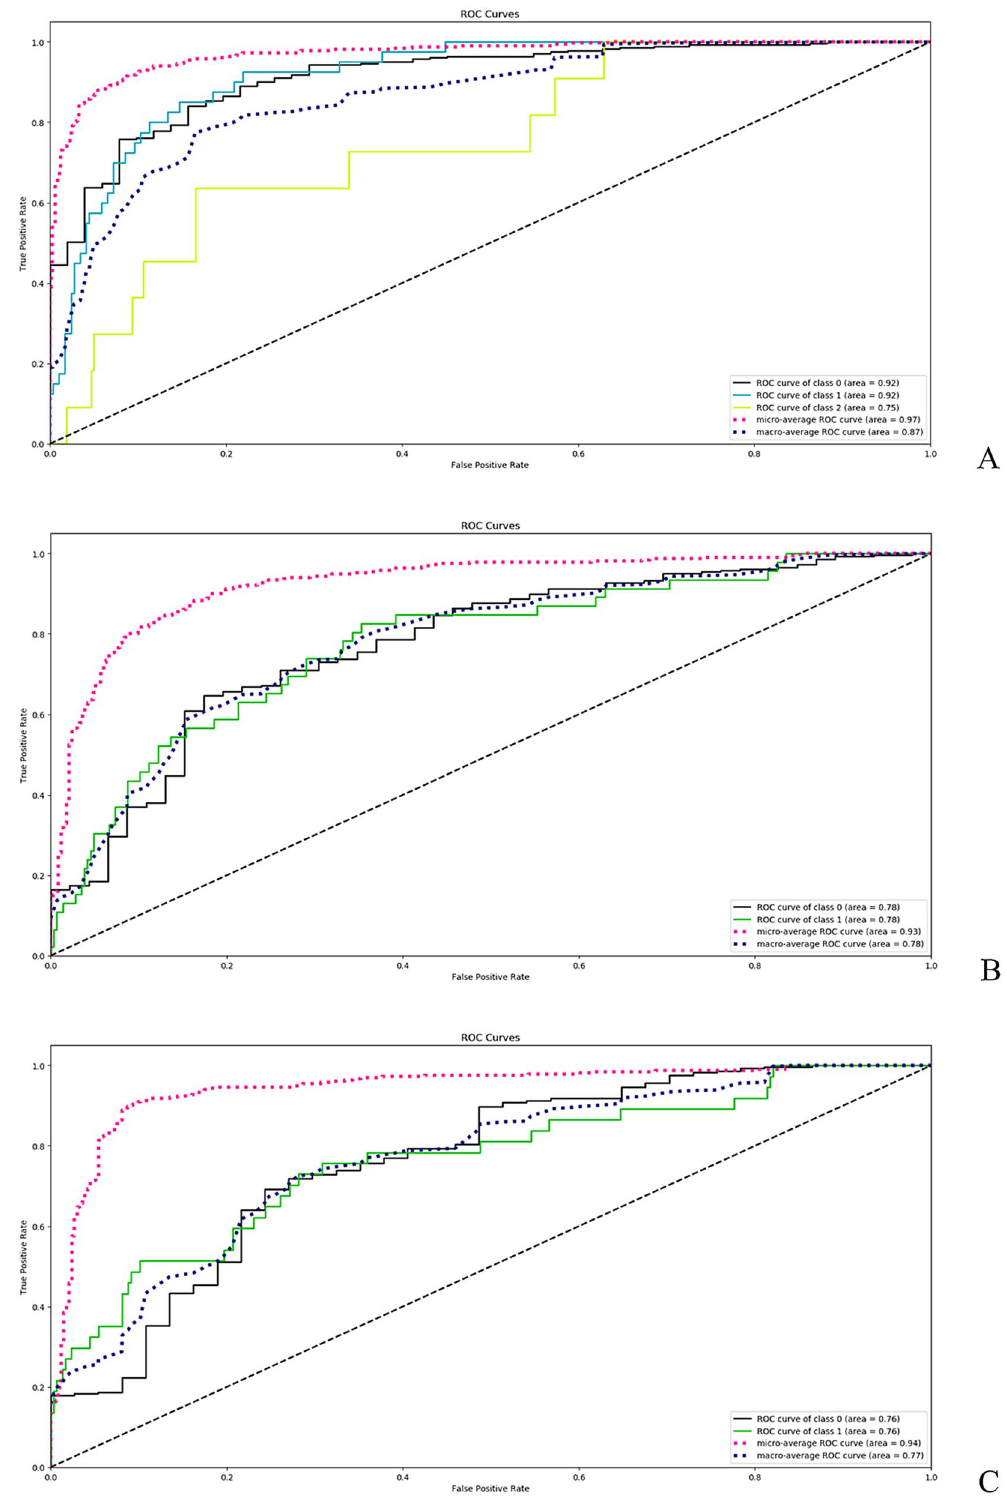
Figure 2. Predictive ability of machine-learning derived models for ( A ) “therapeutic failure”; ( B ) “stroke/TIA”; ( C ) “major